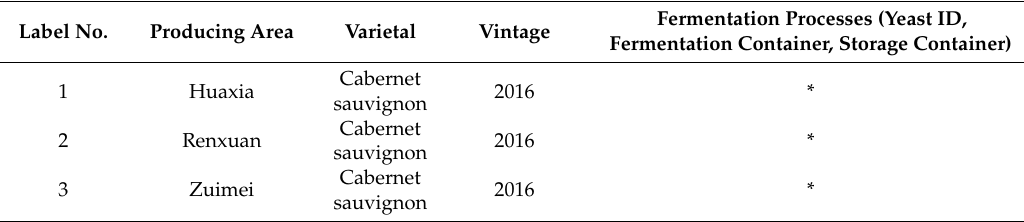
Table 2. Details of wine samples with different producing area.